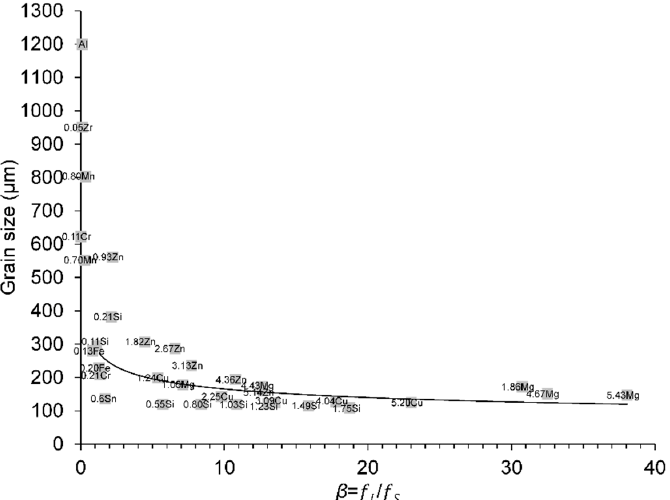
Figure 4. Variation in grain size values from Spittle and Sadli, data from [40] with the true β values at Δ T = 0.5 K for different solute additions in binary Al alloys. The dashed line corresponds to the true β of 1.14, which was used as a criterion for CET under quasi -isothermal conditions [16]. All alloys with β < 1.14 (circle points) exhibited a columnar grain structure (see Ref. [16] for details). The Al circle point represents the initial columnar grain size of CP Al with a grain refiner addition of 0.01% Ti for reference. The reader is referred to the web version of this article for alloy compositions given in data-point labels.